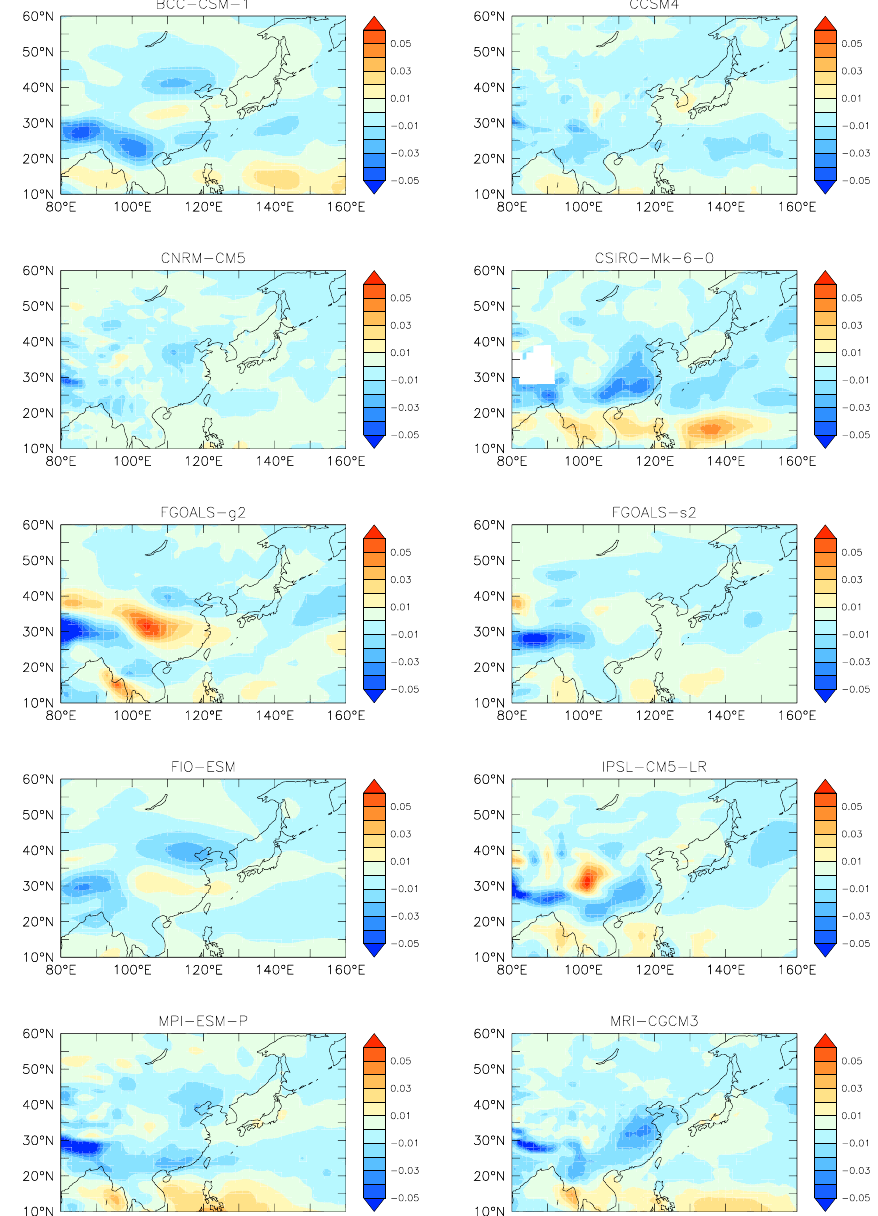
Fig. 6. The changes of the vertical velocity at mid-Holocene for the PMIP3 model in this study. Units: d p /d t .